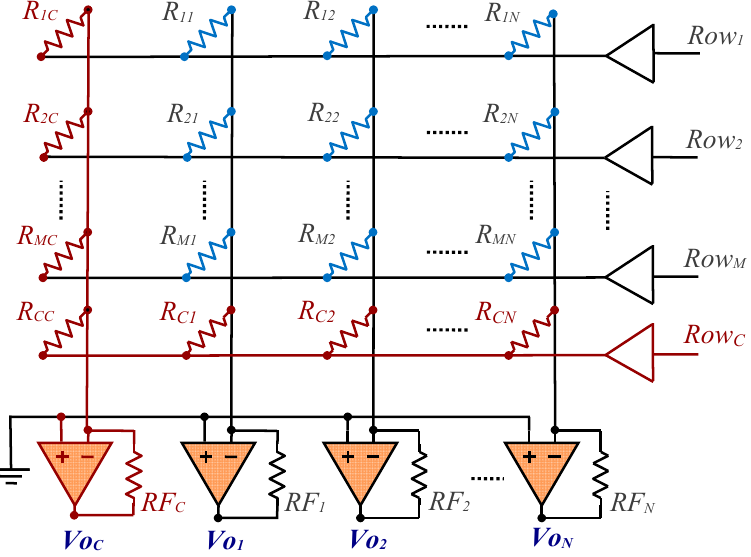
Figure 4. Circuit with the resistor array to be measured (in blue) along with the row and additional calibration column (in red) for Method II.